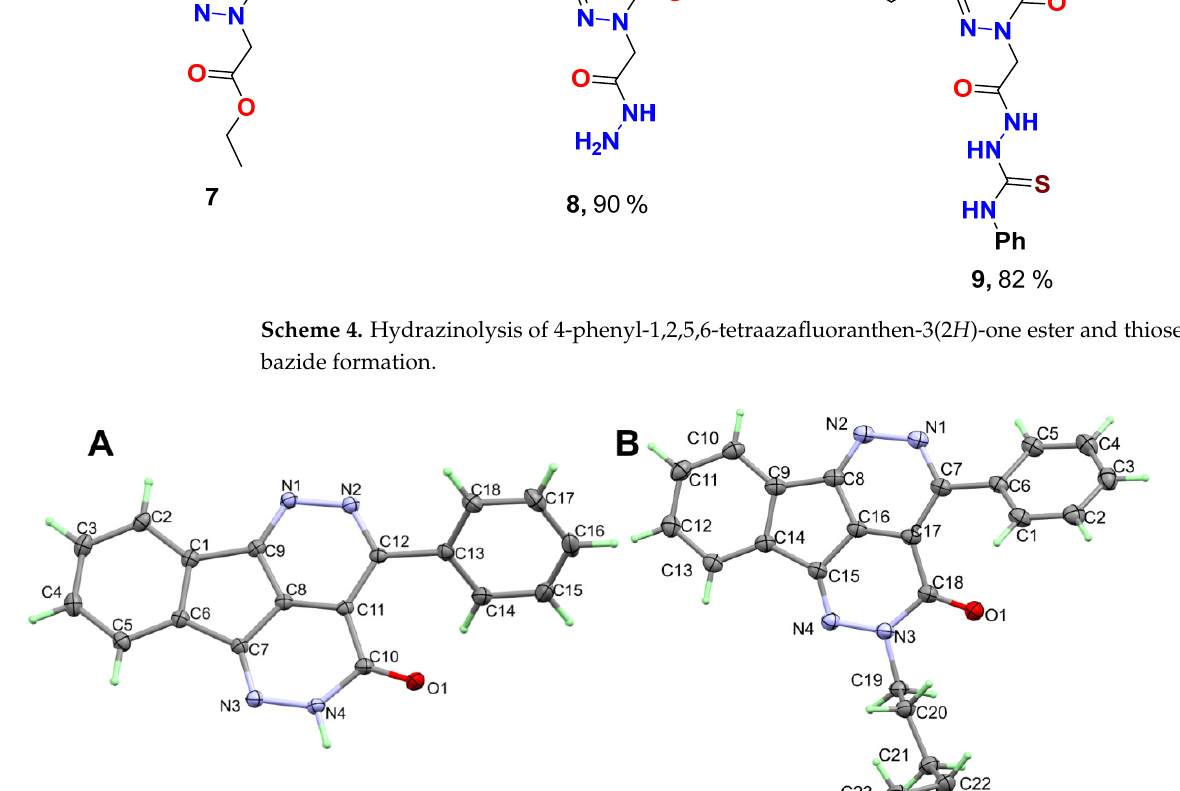
Figure 2. ORTEP of compounds 2 ( A ) and 6 ( B ). Table 1. Crystal data of 2 and 6.